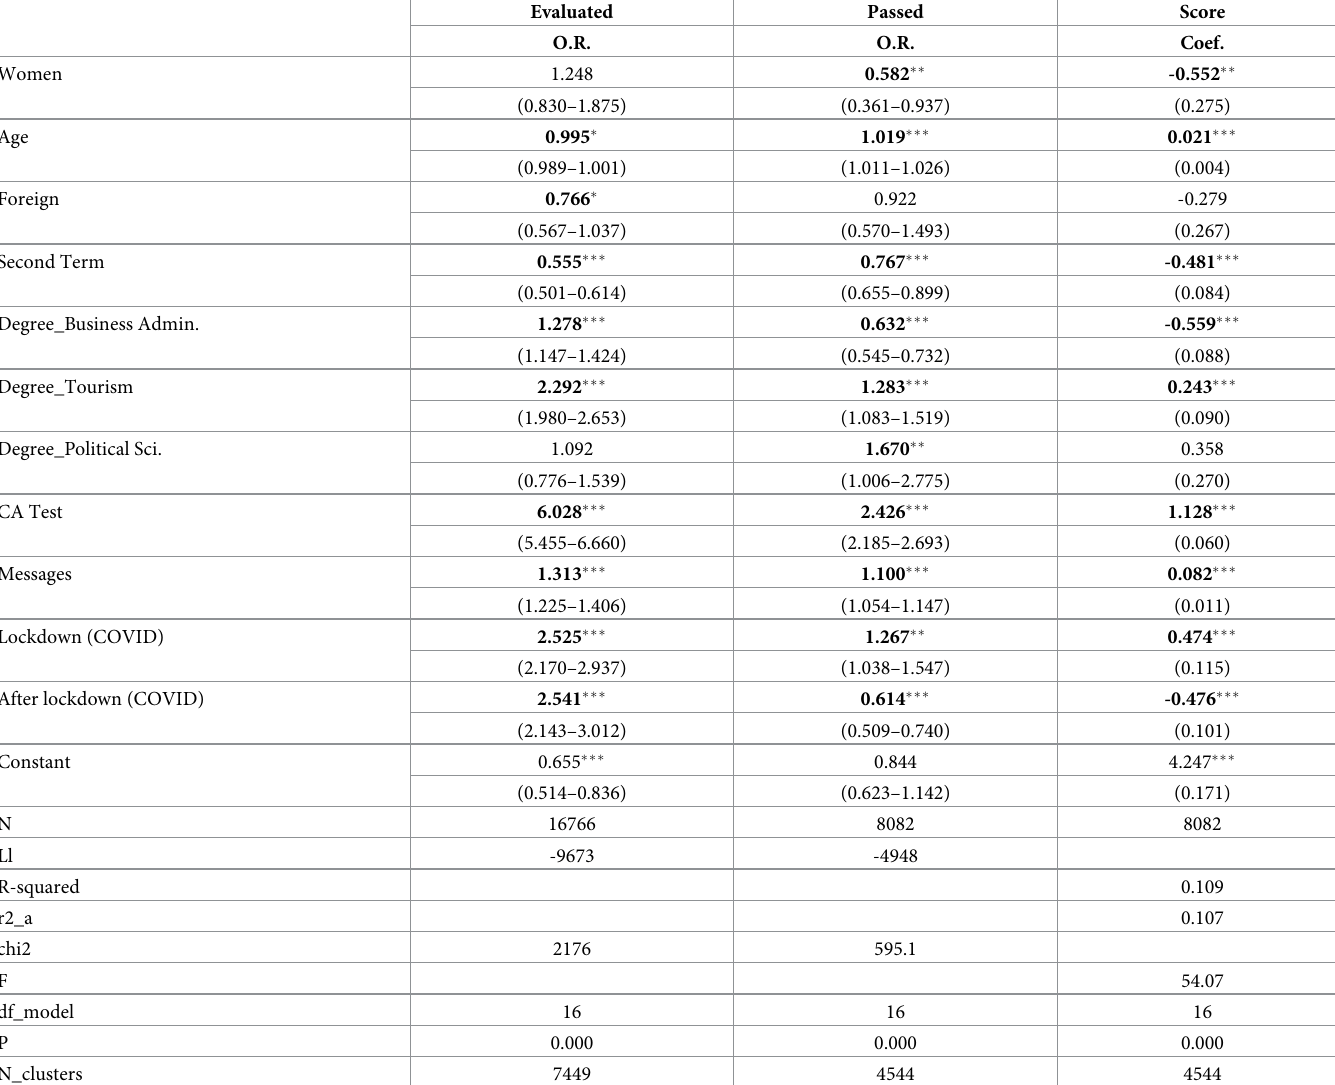
Table 6. Selected estimation results of the whole model with interactions: Main effects.